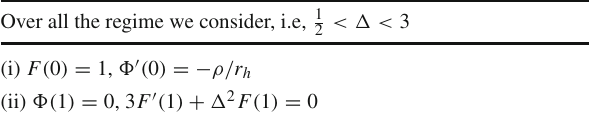
Table 6 Boundary condition of F ( z ) and (cid:6)( z ) at the origin and the